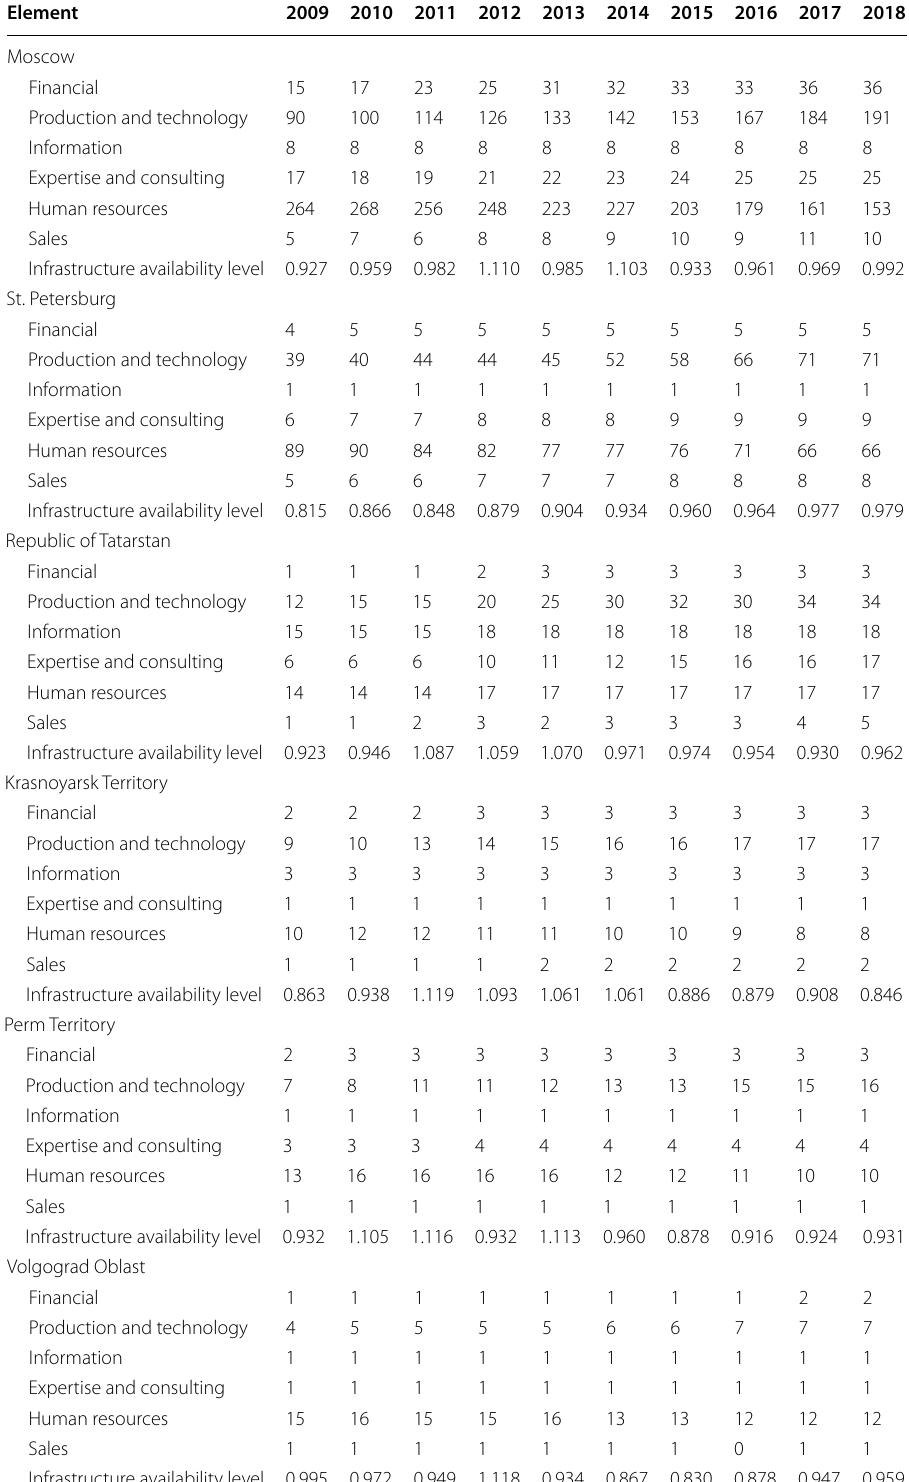
Table 4 Distribution of the facilities of the support infrastructure for scientific, research, technical and innovation activity by elements